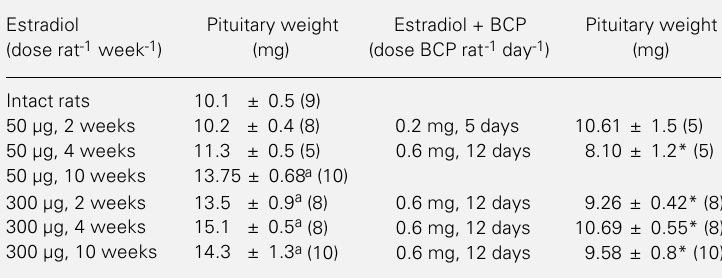
Table 1 - Effect of the administration of bromocriptine, a dopamine agonist, on pituitary wet weights of intact or ovariectomized rats treated with estradiol valerate. Results are reported as mean – SEM. The number of animals is given in parentheses. BCP, Bromocriptine. a P<0.05 versus intact rats (Duncan(cid:146)s test); *P<0.05 versus estra- diol ( t